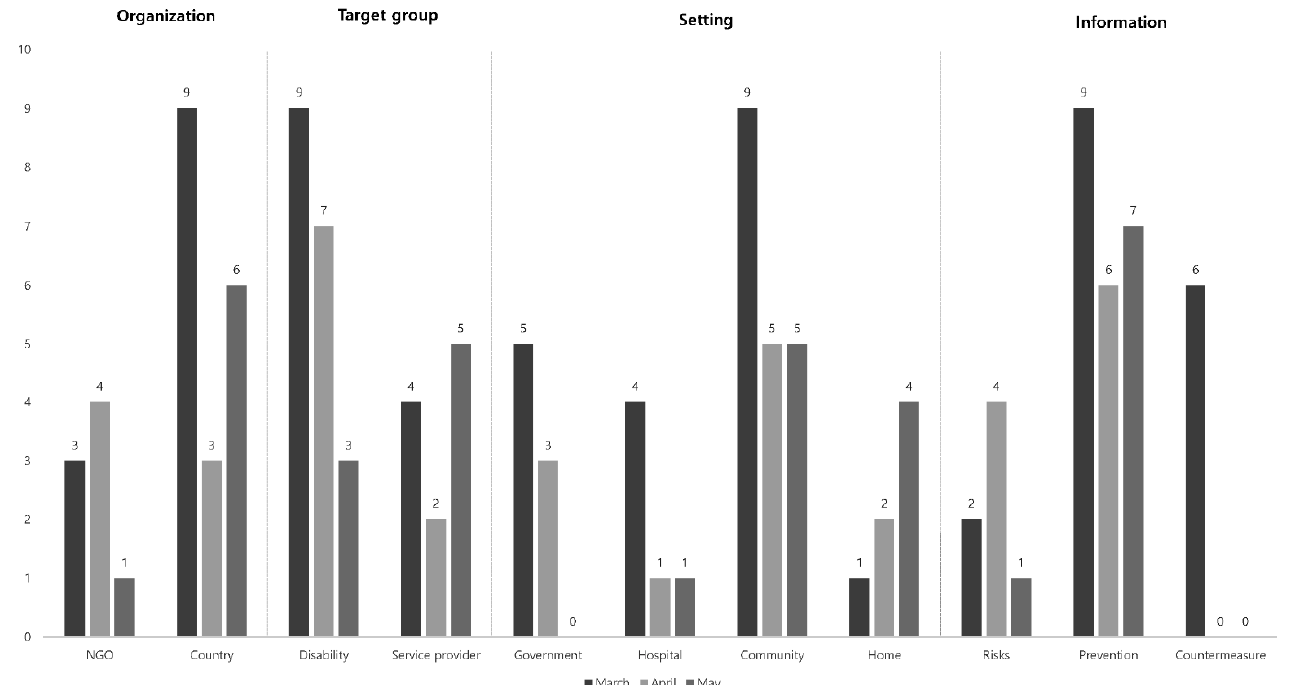
Figure 2. Guidelines published by entities between March through May.